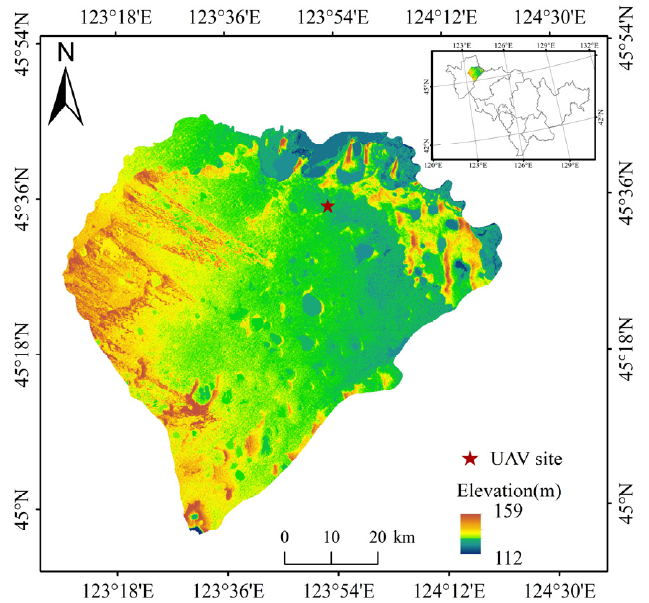
Figure 1. Geographical location of Da’an City in western Jilin Province (The red star represents the location where the UAV field survey was conducted).